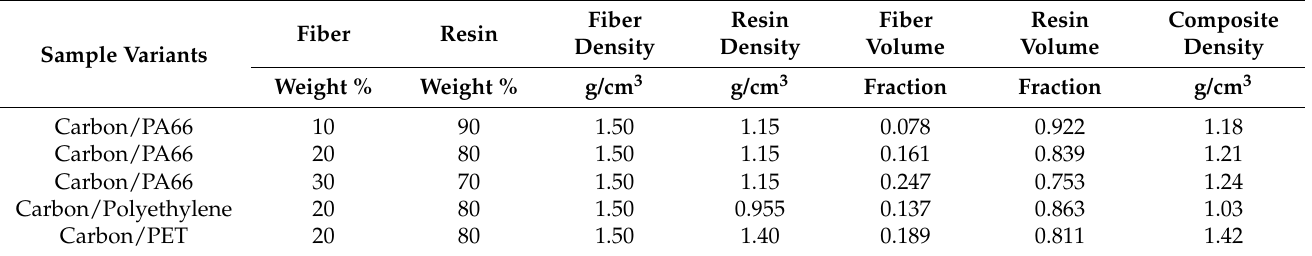
Table 10. Density of the rCF thermoplastic variants.